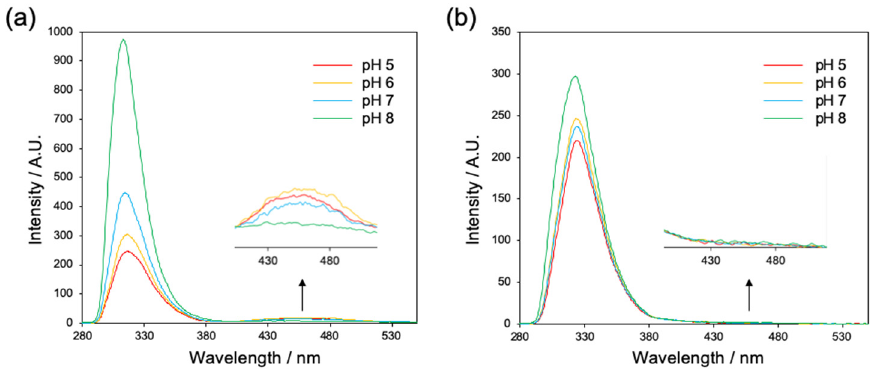
Figure 2. Fluorescence spectra of Fmoc-L 2 QG ( a ) and Fmoc-L 3 QG ( b ) at pH 5–8 above their critical aggregation concentrations (CACs). λ ex = 265 nm.